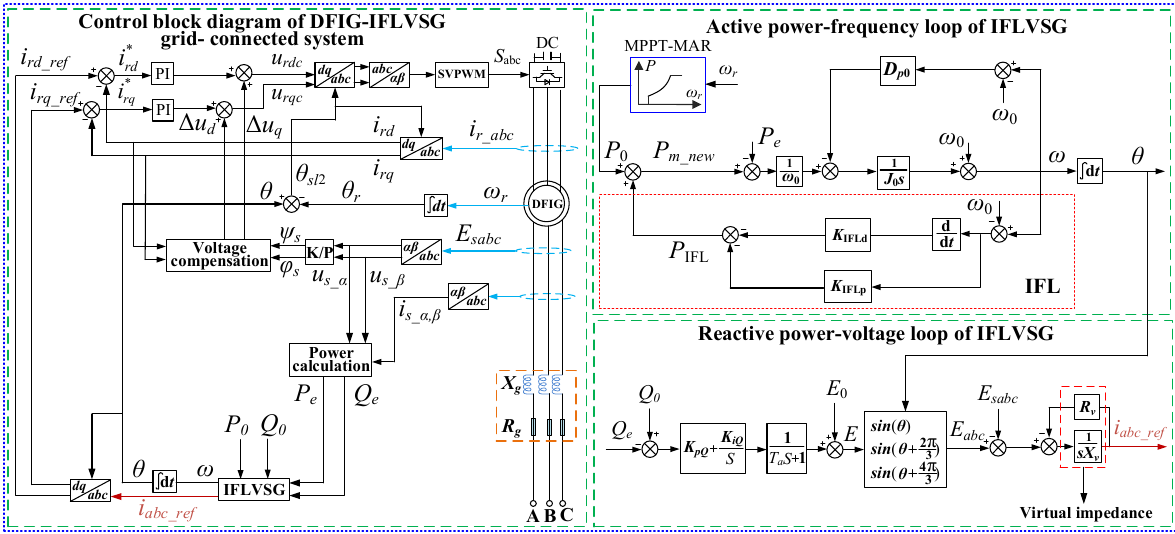
Figure 1. Structure of the DFIG ‐ IFLVSG grid ‐ connected system.